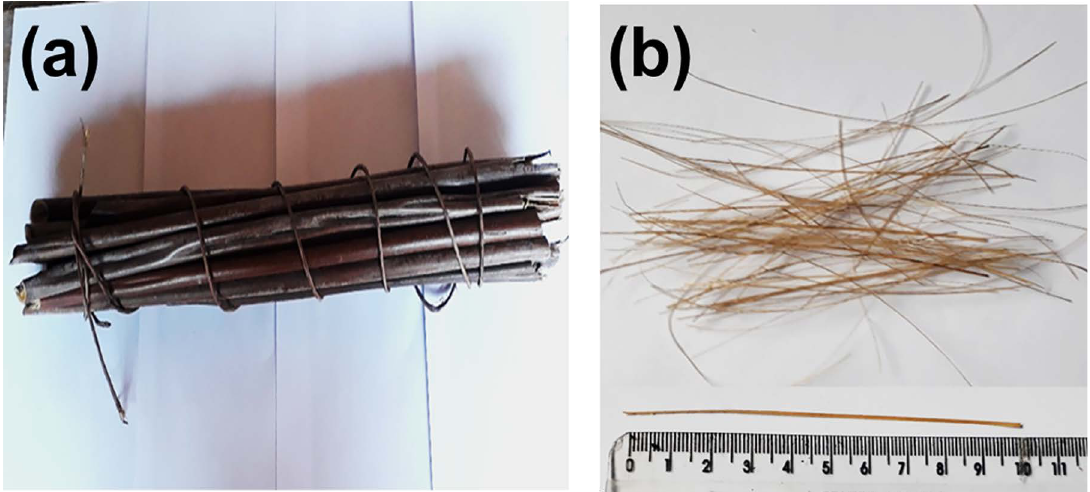
Figure 2. As received bundle of guaruman stems (a) and extracted fibers (b).